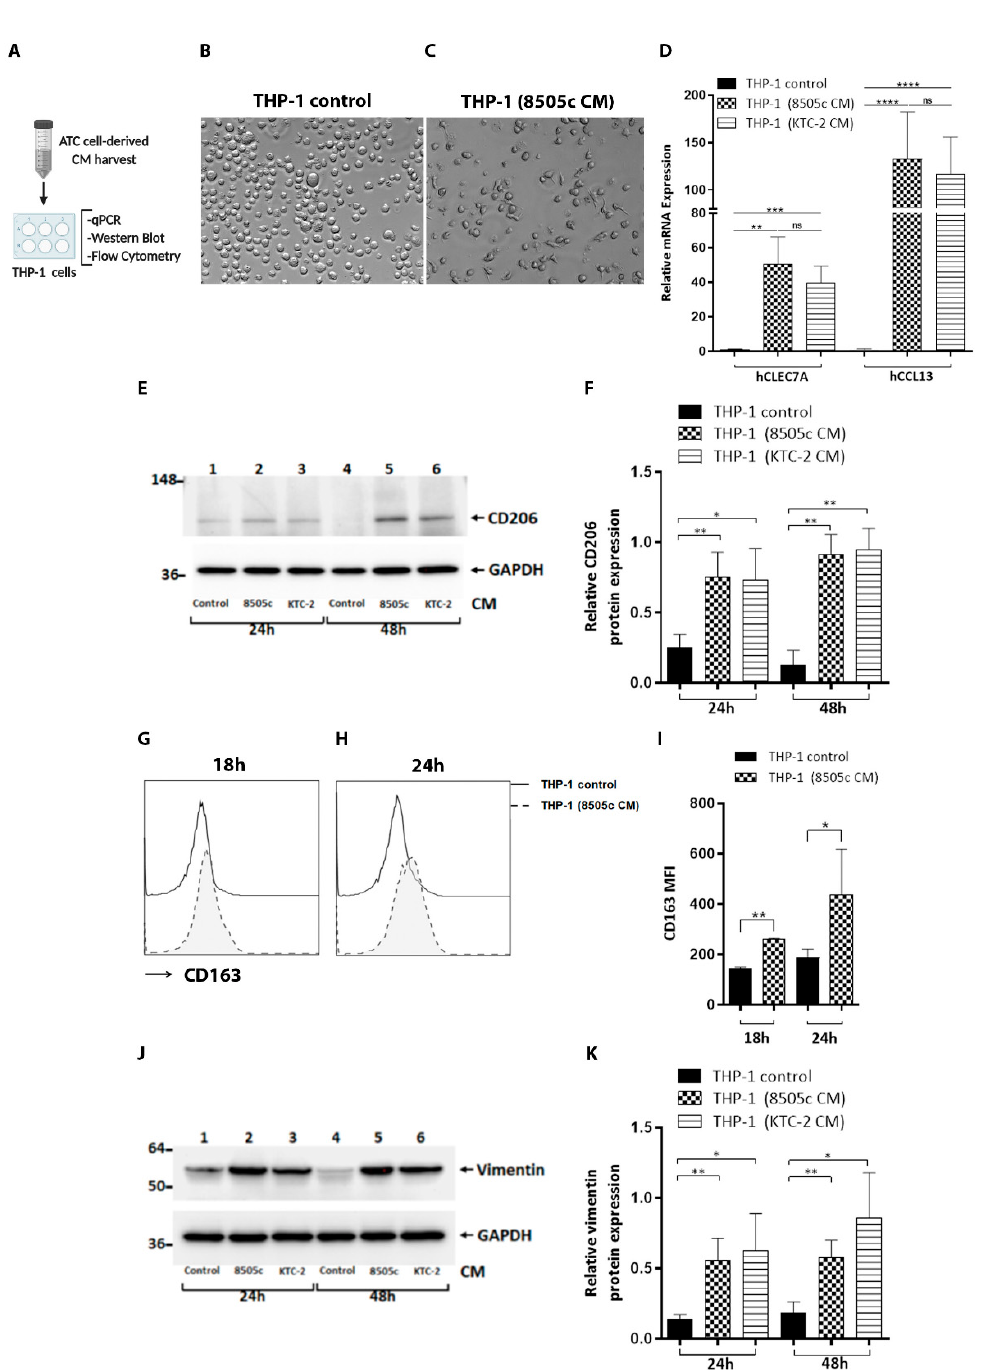
Figure 1. Differentiation of THP-1 monocytes into M2-like macrophages. ATC cell-derived CM induced the expression of M2 macrophage markers in human monocytes. ( A ) Schematic representation of CM preparation from ATC cells and treatment of THP-1 cells with complete media containing 5% FBS or with 100% CM of ATC cell-derived CM for different periods of time (18 h, 24 h, 48 h), and a variety of parameters were analyzed. ( B , C ) Soluble factors derived from ATC cells induced morphological changes in THP-1 cells. Monocytes were incubated with complete media containing 5% FBS or treated with ATC cell-derived CM for 24 h. Representative bright-field imaging of THP- 1 control ( B ) or treated with 8505c-derived CM, THP-1 (8505c CM) ( C ). ( D ) THP-1 cells treated with ATC cell-derived CM for 24 h showed a significant increase of mRNA expression of hCLEC7A or Dectin-1 and hCCL13 (both markers for M2 macrophages), compared with complete media, meas- ured by RT-qPCR. ( E , F ) Immunoblot analysis of CD206 in THP-1 cells grown under normal condi- tions (THP-1 control) or exposed to derived from ATC cells for 24 h and 48 h ( E ). Quantification of